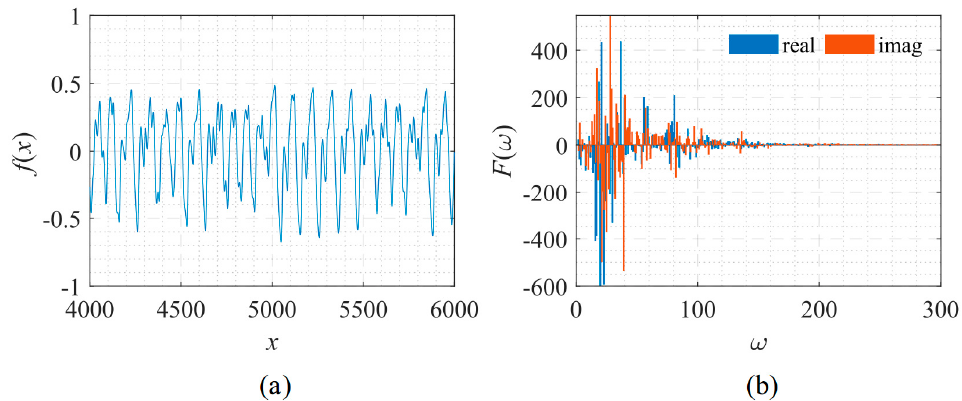
Figure 26. Signal described by Equation (15) with its frequency spectrum. ( a ) The function to be fitted. ( b ) The spectrum of the function.